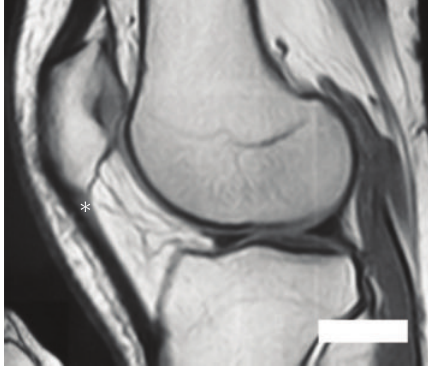
Figure 1: Preoperative magnetic resonance imaging showing hypodens area in the proximal aspect of the patellar tendon ( ∗